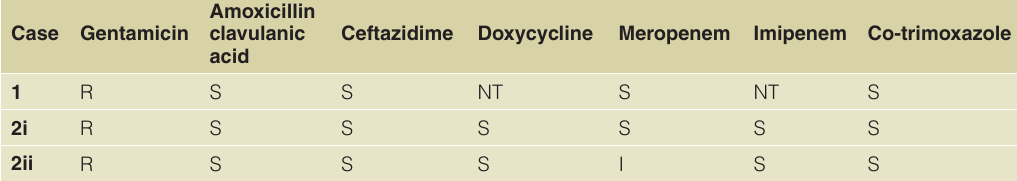
Table 1. Susceptibility profiles of B. pseudomallei isolates from case one (1) and case two (2i and